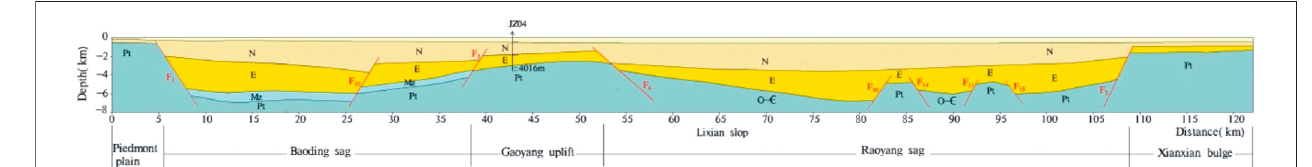
FIGURE 6 | Geological interpretation of